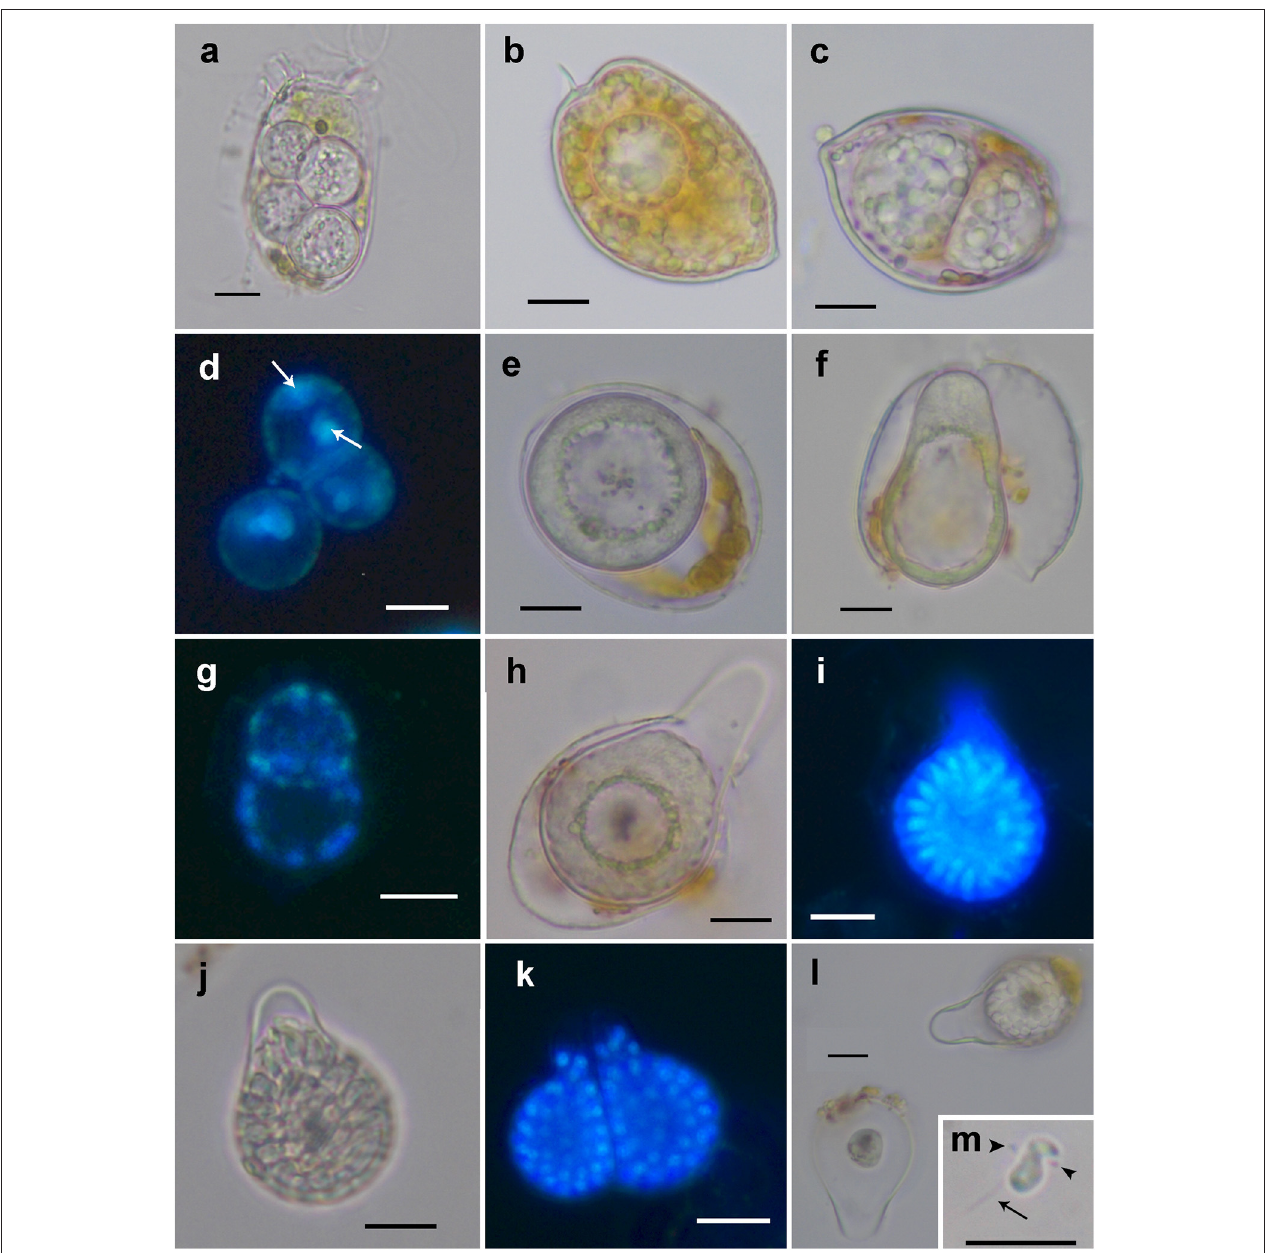
FIGURE 1 | Light microscopy and epifluorescence micrographs showing the life-cycle stages of Dinovorax pyriformis during host infection. (a) Four early trophonts infecting a Dinophysis sacculus cell. (b) Early trophont infecting a Prorocentrum micans cell. (c) Double infection of two late trophonts in a P. micans cell. (d) Epifluorescence image of three early sporocytes stained with DAPI showing two nuclei (arrows). (e) Early sporocyte. The entire cytoplasmatic content aggregates in the periphery while the inner area is occupied by amorphous hyaline material. (f) Early sporocyte forming the germ-tube. (g) Epifluorescence image of two early sporocytes stained with DAPI showing several nuclei distributed along the cell periphery. (h) Early sporocyte after the formation of the germ-tube. (i) Epifluorescence image of a late sporocyte stained with DAPI showing numerous elongated nuclei of zoospores in formation arranged around a central body. (j) Late sporocyte with zoospores in formation arranged around a central body. (k) Epifluorescence image of two mature sporangia with many visible nuclei of mature zoospores. At this late stage, zoospores nucleus is rounded. (l) Empty sporangium (left) with only the central body remaining in it and early sporocyte (right). (m) Zoospore showing its characteristic sigmoid shape. The anterior (arrowheads) and posterior flagellum (arrow) can be seen. Scale bars = 10 µ m.